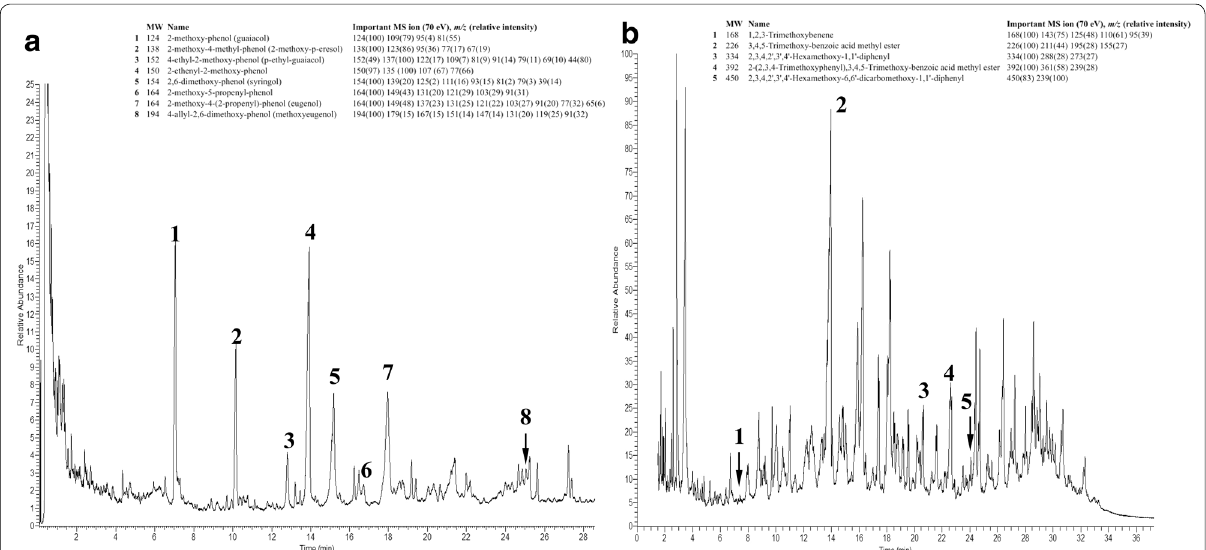
Fig. 3 Chromatograms of Pyrolysis GC/MS experiments of fraction III and peaks identification. a Pyr/GC/MS (total ion current) and b: THM/GC/MS (total ion current)